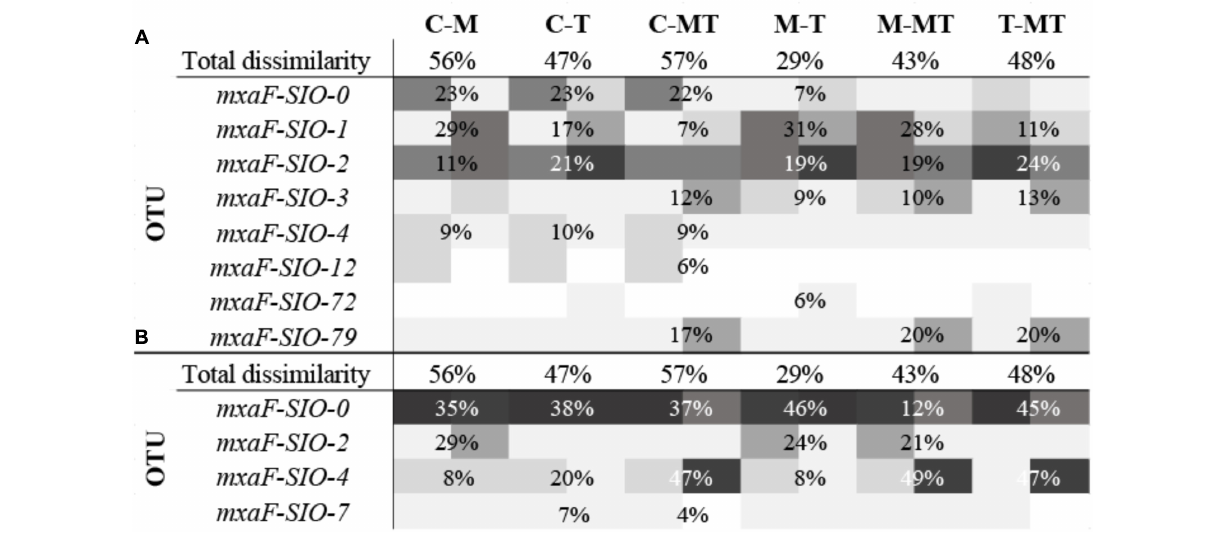
FIGURE 5 | Heatmap of percent relative abundance of bacterial OTUs responsible for more than 70% of the dissimilarity between two samples (calculated by Bray Curtis, SIMPER analysis), in winter (A) and in summer (B) . The percentages represent the average contribution of an OTU to the dissimilarity between the samples. Total dissimilarity includes the whole communities of the sample duplicates. C-M, controls to MetOH; C-T, controls to TMAO; C-MT, controls to metOH + TMAO; M-T, MetOH to TMAO; M-MT, MetOH to MetOH + TMAO; T-MT, TMAO to MetOH +